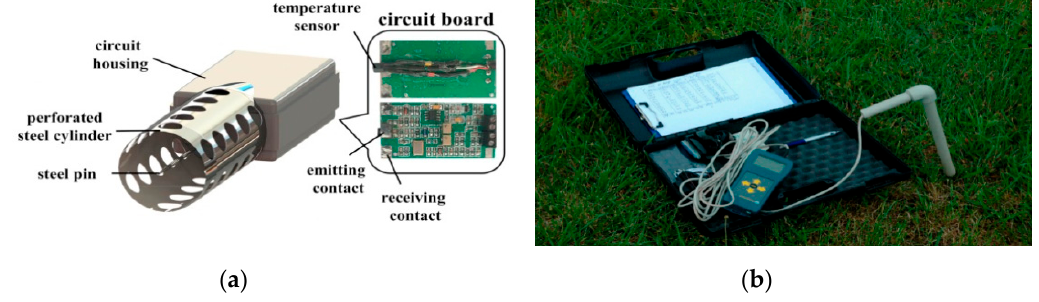
Figure 5. Some latest sensor equipment: ( a ) a perforated cylinder coaxial dielectric sensor for measuring soil water content [47] and ( b ) a time ‐ domain reflectometry sensor for measuring soil moisture [48].